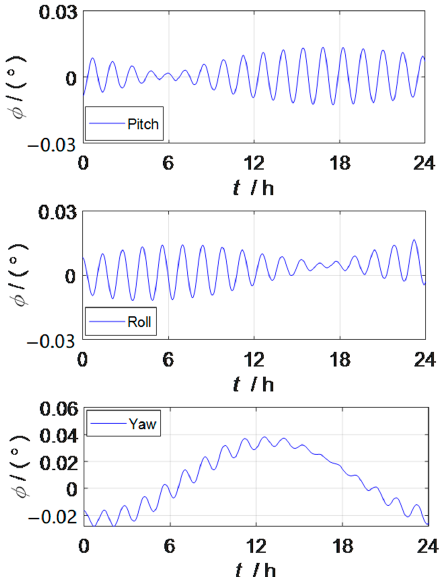
Figure 1. Attitude error of the strapdown inertial navigation system.